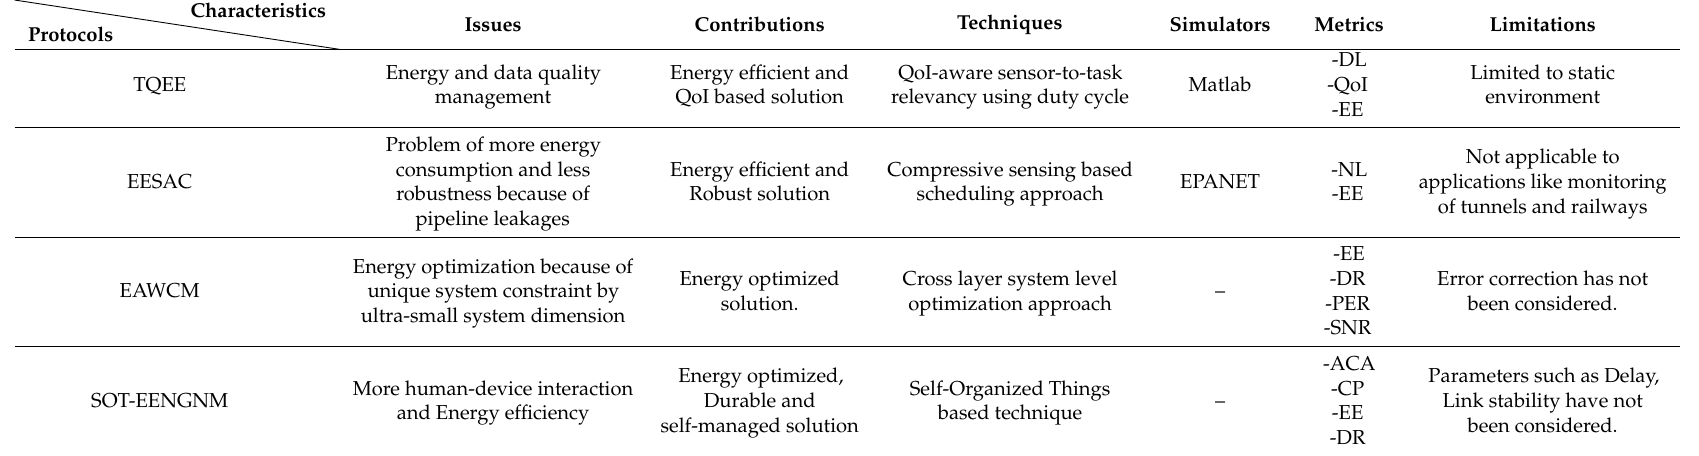
Table 4. Summary of energy efficient techniques at sensing layer.